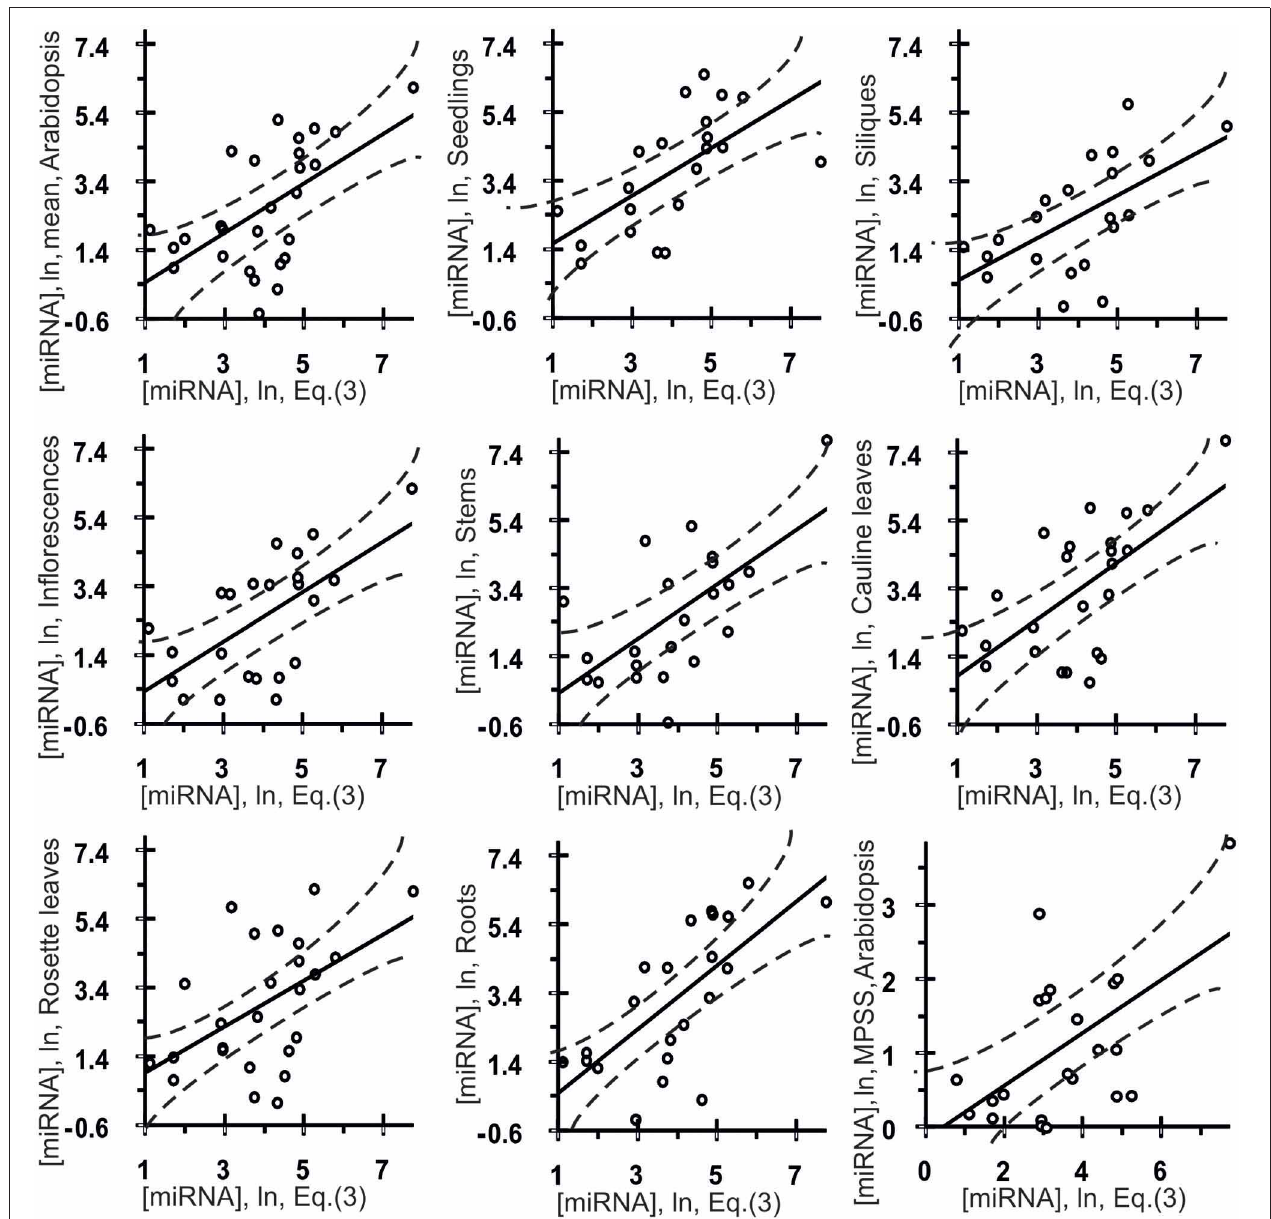
FIGURE 4 | Control test of the final equation (3), the x -axis, derived with ACTIVITY outputs (Ponomarenko et al., 1997) on the training dataset (Table 1) and using independent experimental data (the y -axis) taken from various data sources. Twenty seven correlations in Arabidopsis ( Table 3 ) between the miRNA abundance estimated by Equation (3), the x -axis, and those measured experimentally, the y